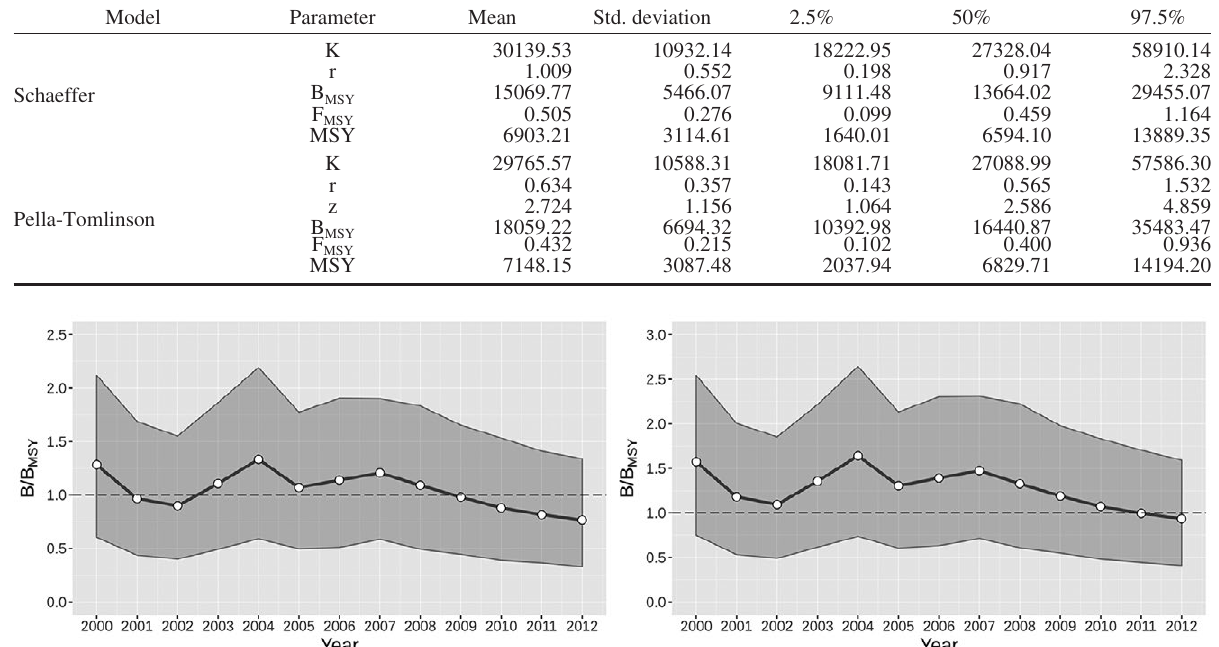
Fig. 7. – Time series of ratios between estimated biomass and biomass at maximum sustainable yield (B surplus production models. Left, Pella-Tomlinson model; Right, Schaeffer